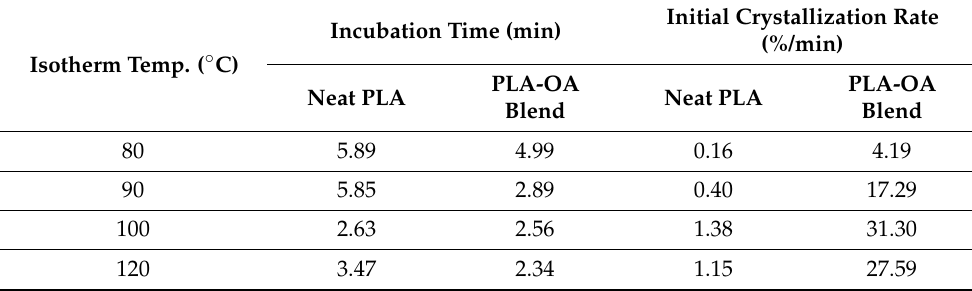
Table 3. Incubation time and initial crystallization rate for neat PLA and PLA-OA blends at different isotherm